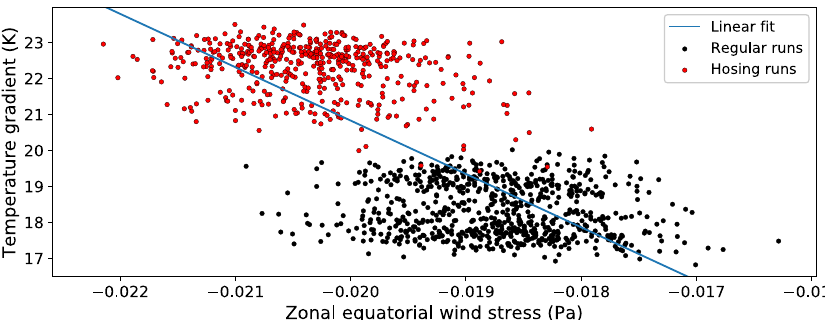
Figure 7. Zonal equatorial wind stress versus the Atlantic temperature gradient. Data from the ESSENCE (Ensemble SimulationS of Extreme weather events under Nonlinear Climate changE) project are used, where the black dots refer to five members of the standard ensemble with SRES-A1b forcing (1950–2100 period ), and the red dots refer to five members of the HOSING-1 ensemble where in 2000 a freshwater perturbation is applied (i.e. 2000–2100 period). A 5-year running mean is applied, yearly averages are shown. The zonal equatorial wind stress is defined here as the average zonal wind stress over the 0–10 ◦ N latitudinal band. The Atlantic temperature gradient is defined as the difference between the SST in a northern box (50–60 ◦ N, 50–20 ◦ W) and a southern box (0–20 ◦ N, 45–20 ◦ W). The blue line indicates a linear